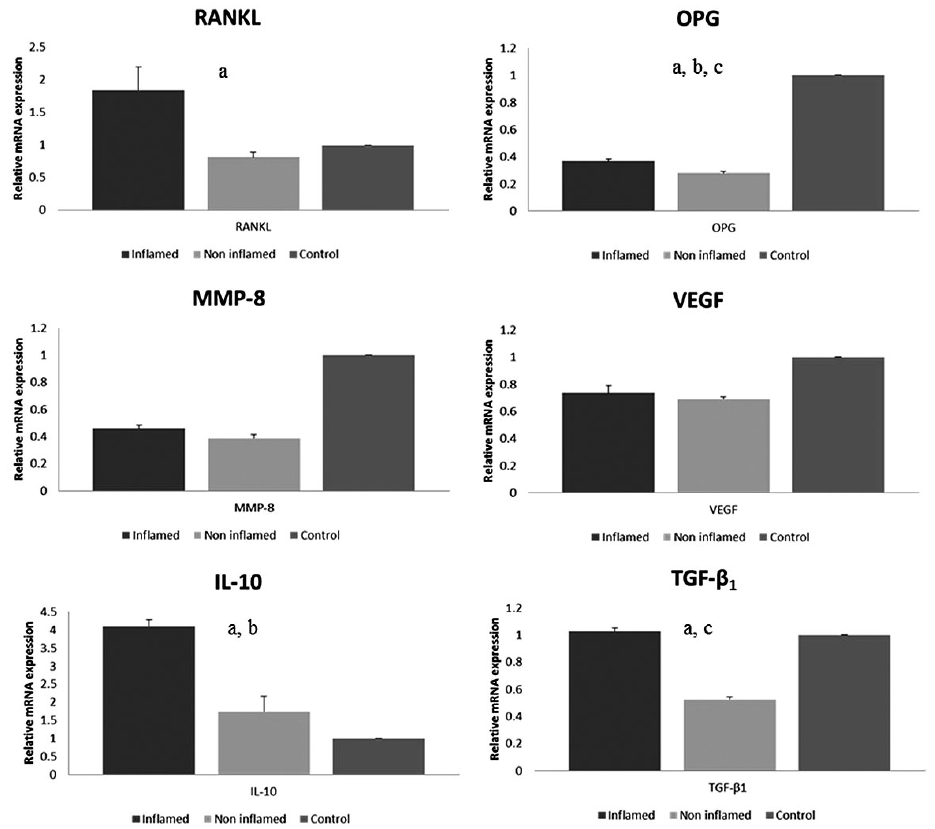
Figure 3- Relative mRNA expression of RANKL, OPG, MMP-8, VEGF, IL-10 and TGF-β1 in inflamed, non-inflamed and control sites. Kruskal-Wallis test and ANOVA test. a: significant difference between inflamed and non-inflamed sites b: significant difference between inflamed and control sites c: significant difference between control and non-inflamed sites. RANKL: Receptor activator of nuclear factor ĸB; OPG: Osteoprotegerin; VEGF: Vascular endothelial growth factor; IL-10: Interleukin-10; MMP-8: Matrix metalloproteinase-8; TGF-β1: Transforming growth factor-